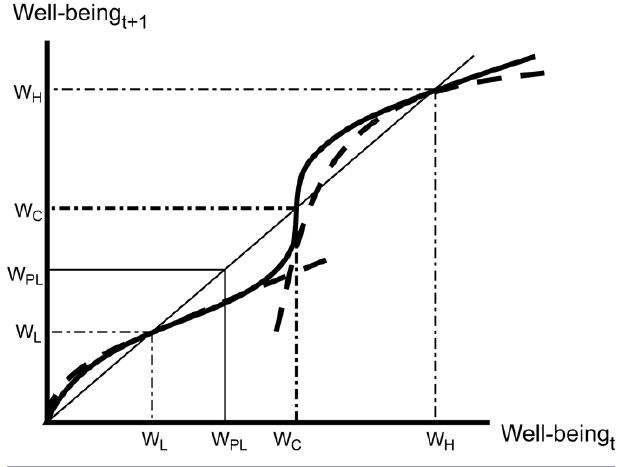
Fig. 1 . Represents well-being dynamics under the poverty trap hypothesis, reproduced from Barrett and Swallow (2006) with permission from